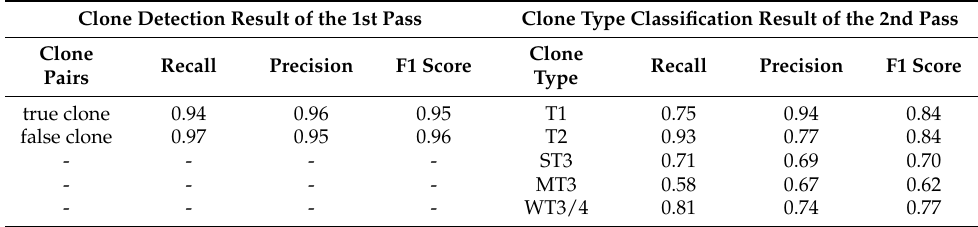
Table 4. Results on clone detection of the 1st pass and clone type classification of the 2nd pass. Clone Detection Result of the 1st Pass